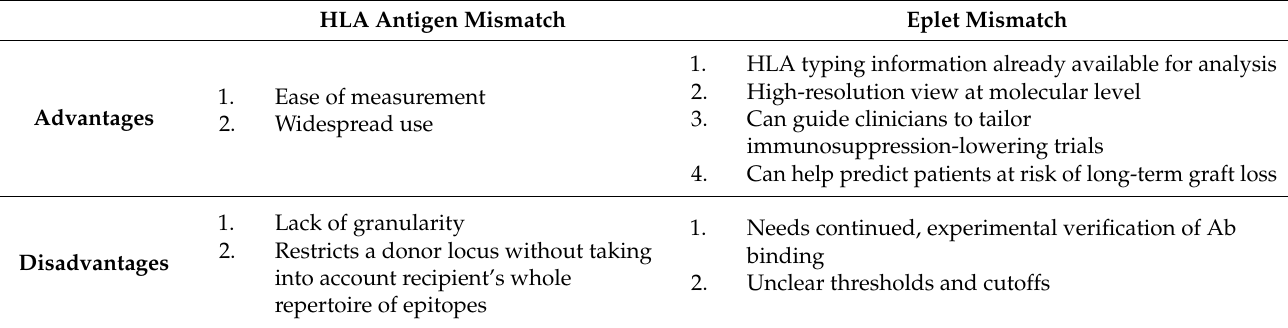
Table 2. Comparison of antigen-level and epitope-level